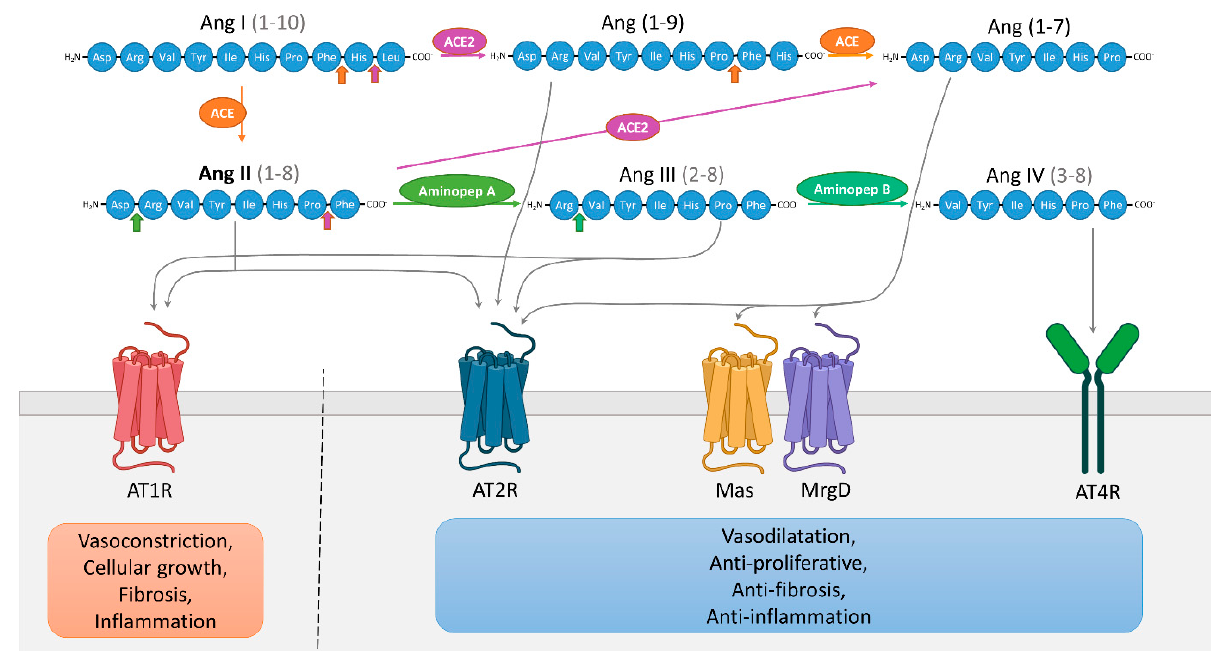
Figure 1. Schematic representation of the renin-angiotensin system (RAS). Angiotensin (Ang) I is cleaved by angiotensin- converting enzyme (ACE) to Ang II which can be then cleaved to Ang III by aminopeptidase A, then further cleaved to Ang IV by aminopeptidase B. Ang I can also be cleaved by ACE2 to produce Ang (1–9) which can be cleaved into Ang (1–7) by ACE. Ang (1–7) can be directly generated from Ang II by ACE2. Ang (1–7) binds and activates the receptors Mas and Mas-related G protein-coupled receptor member D (MrgD), Ang IV binds to AT4R, Ang III activates AT1R and AT2R and Ang (1–9) directly activates AT2R. Functionally, it is possible to simplify the RAS into two distinctive pathways [12]. The first involves over-activation of AT1R by Ang II/Ang III, promoting cellular growth, vasoconstriction, fibrosis and inflammation. The second involves the interactions between AT2R and Ang II/Ang (1–9)/Ang III, but also Ang (1–7) and Mas/MrgD receptors, and Ang IV and AT4R, leading to vasodilatation and anti-proliferative, anti-fibrotic, anti-inflammatory effects.